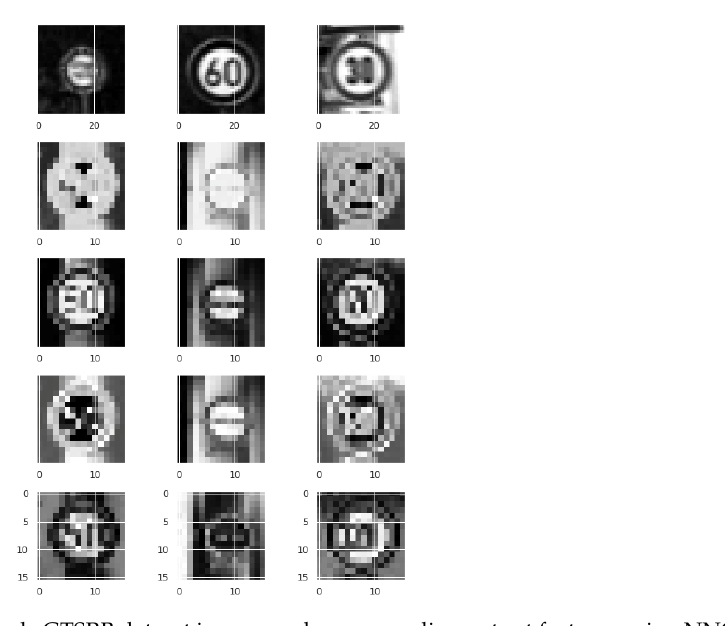
Figure 7. Example GTSRB dataset images and corresponding output features using NNQE circuit.